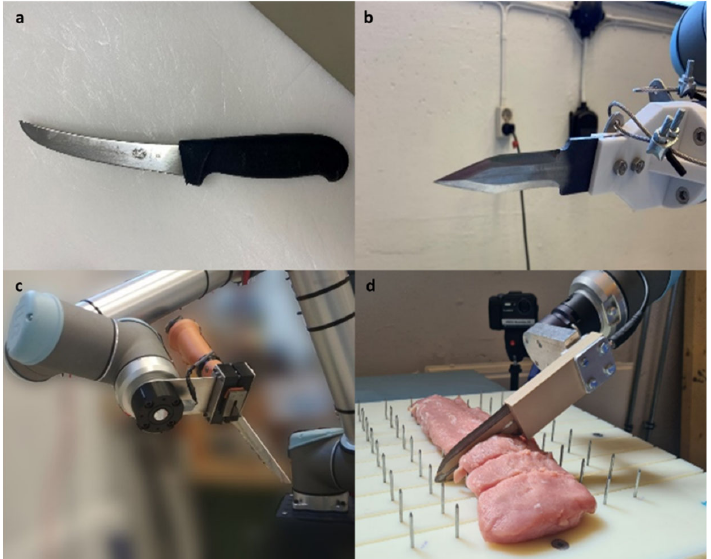
Fig. 1. The four types of knives used in the experiment: (a) The handheld Victorinox knife, (b) The bespoke Uddeholm knife, (c) The EFA 805 air operated power knife, (d) The Smart